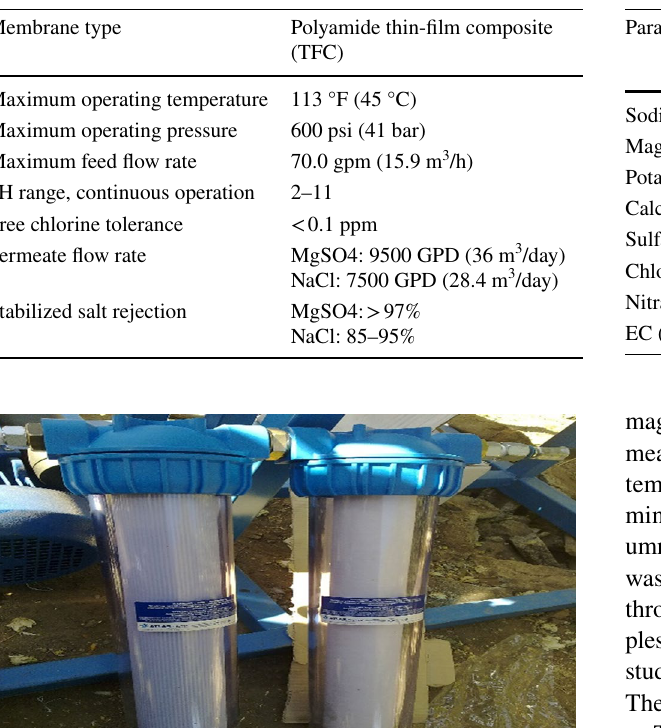
Table 1 Specifications of the membrane